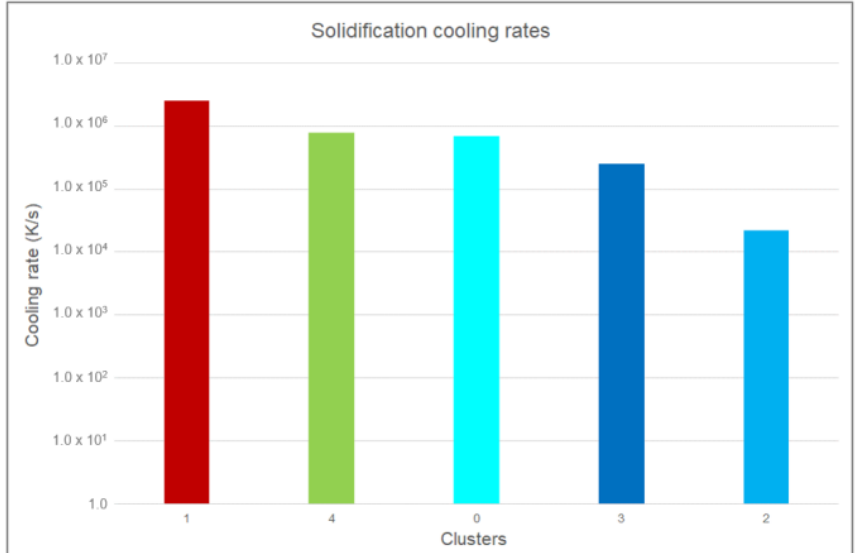
Figure 13. Solidification cooling rate values in different areas of the part.